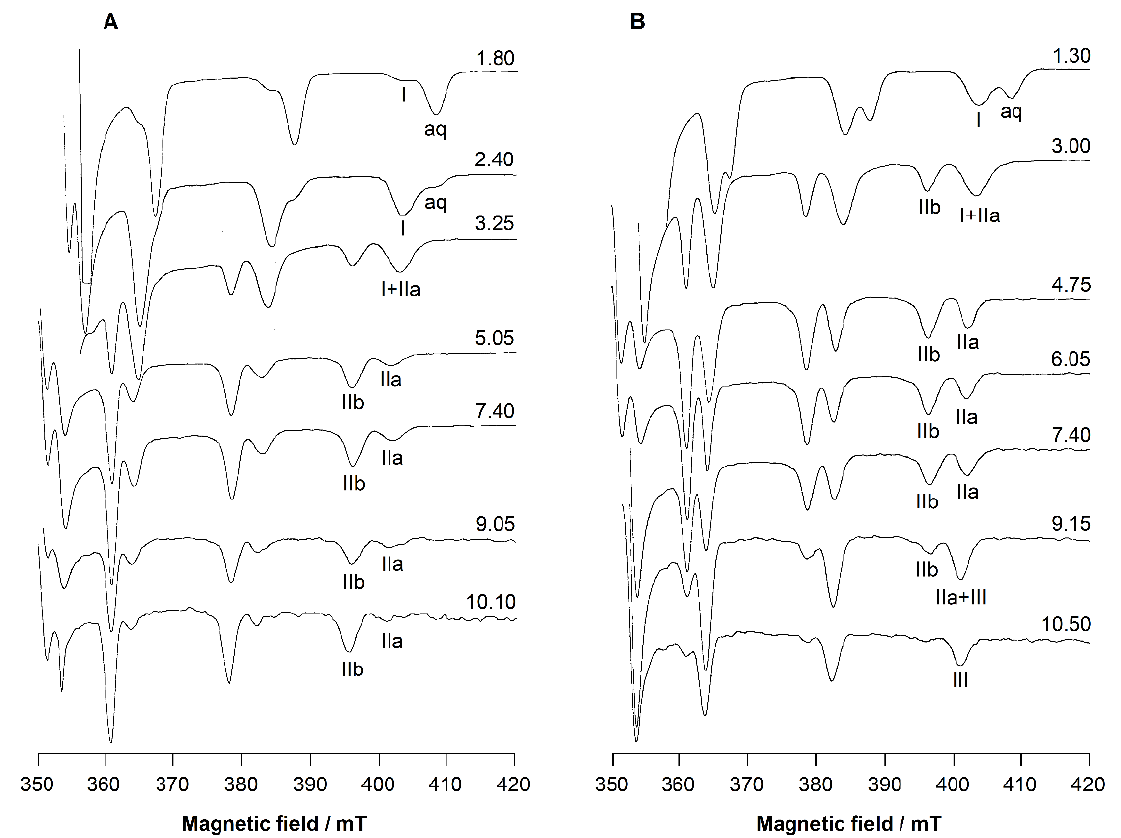
Figure 6. High field region of the anisotropic X-band EPR spectra, at increasing pH, of V IV O 2+ -L5 system at 1:2 V IV O 2+ :ligand molar ratio ( A ) and V IV O 2+ -KC21 system at 1:1 V IV O 2+ :ligand molar ratio ( B ). V IV O 2+ concentration is 2 × 10 −3 M.